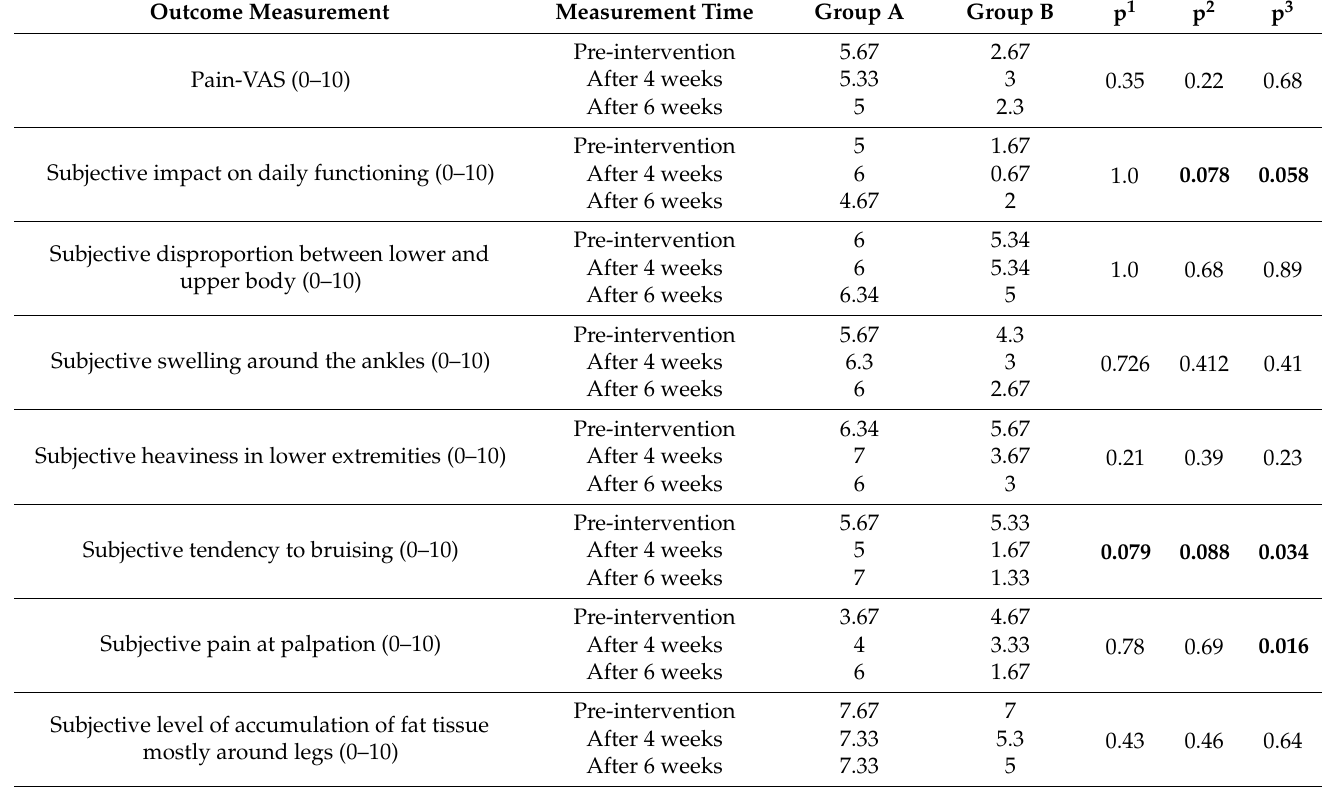
Table 3. Symptom severity pre intervention, after 4 weeks, and after 6